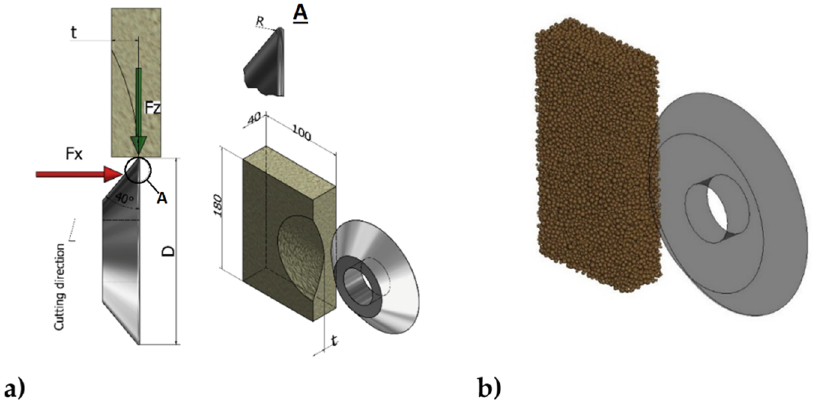
Figure 6. The model used for the tests: ( a ) geometrical parameters of the rock and asymmetrical mini-disk tool model, ( b ) DEM model [27] .